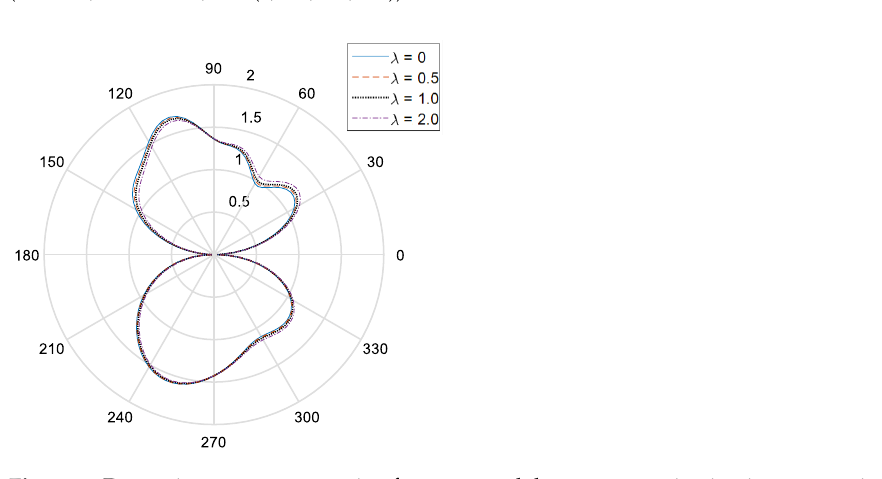
Figure 6. Dynamic stress concentration factor around the upper opening in piezomagnetic composites ( ka = 2.0, d / a = 2.1, λ = (0, 0.5, 1.0,